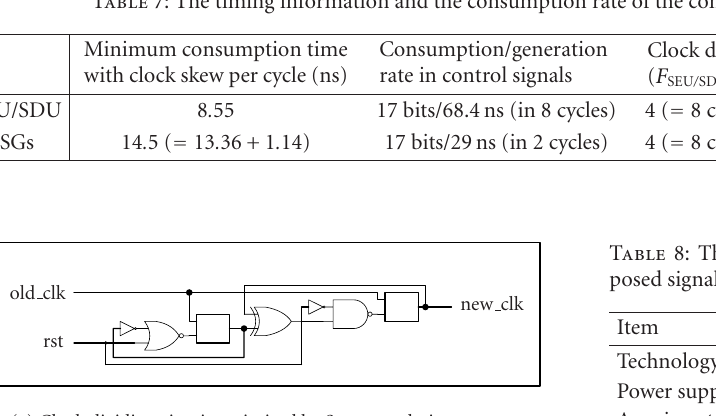
Table 7: The timing information and the consumption rate of the control signals in the SEU/SDU and CBSGs.